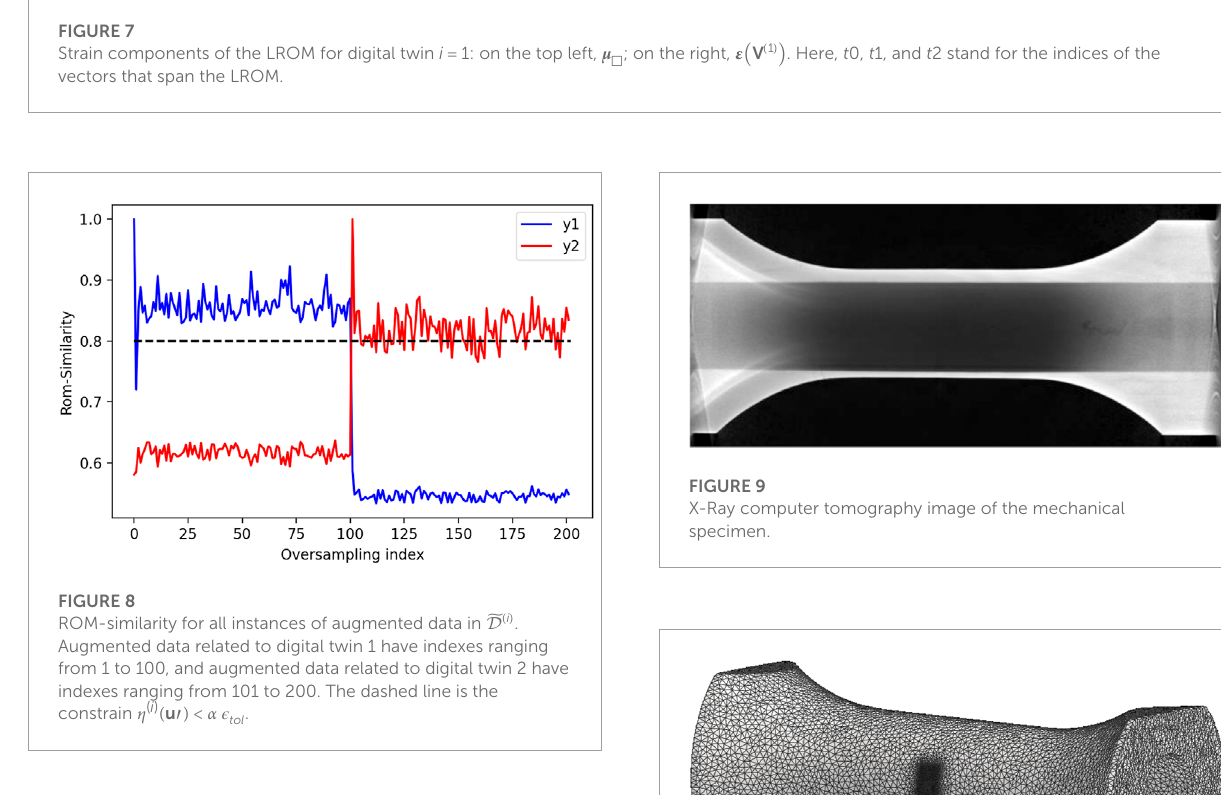
( Figure 9 ), the related finite element mesh ( Figure 10 ), and the finite element predictions of thermo-mechanical variables that are modified at several time steps during the test (on the pruned mesh in Figure 13 ). The problem of data scarcity is particularly pronounced for this kind of DT. In this example, N > 3 . 10 5 , m = 20, and the target reduced dimension of LROM is set up to